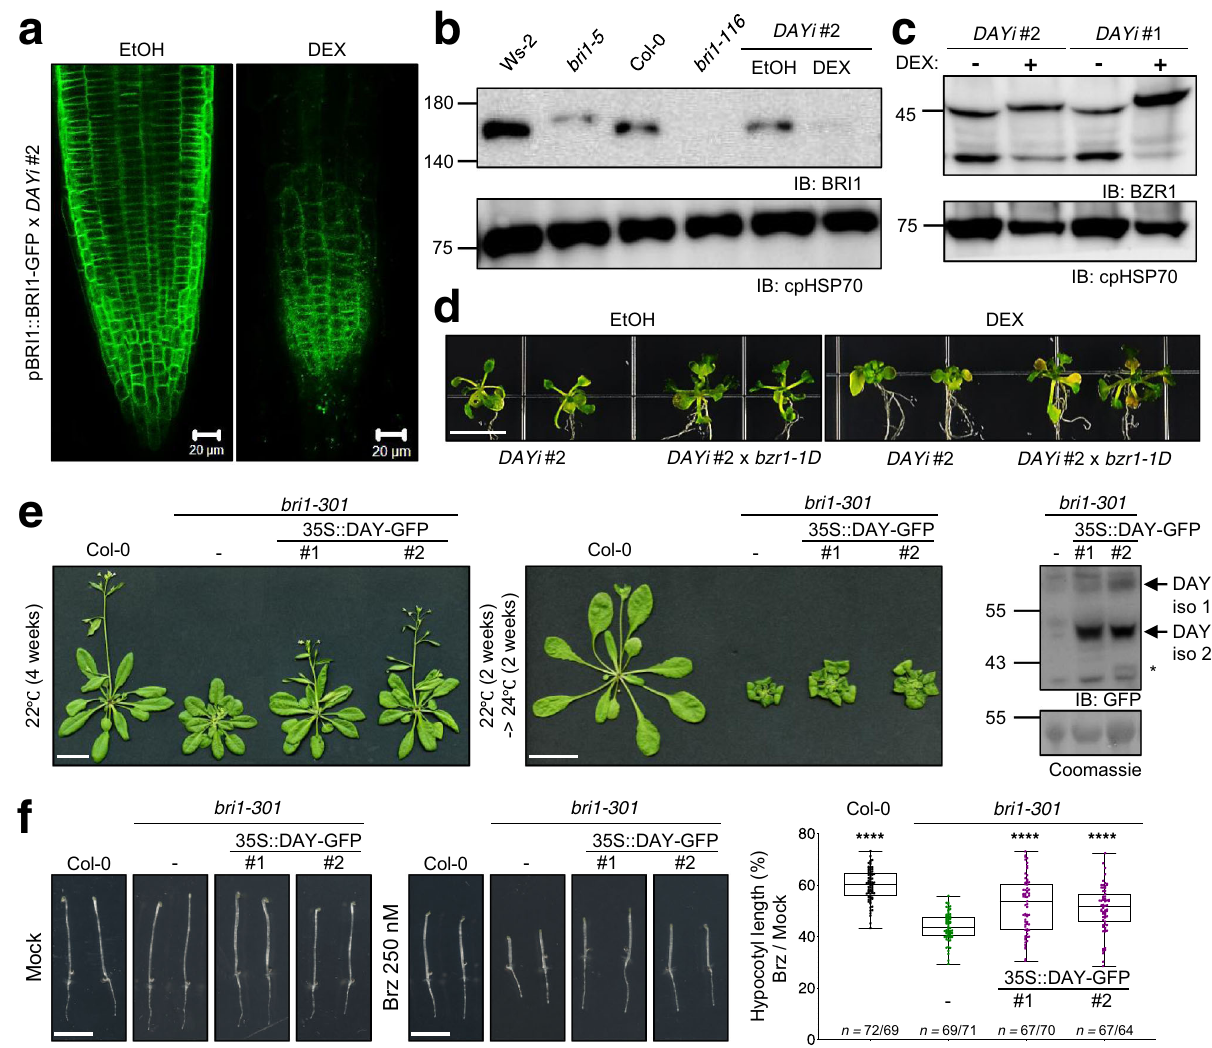
Fig. 4 DAY regulates BRI1 stability. a DAY de fi ciency triggers BRI1 instability. DAY silencing causes aggregation of BRI1-GFP in Arabidopsis roots. The pBRI1::BRI1-GFP × DAYi seedlings were grown in medium containing ethanol or 1 µ M DEX in the light for 9 days, and their roots were observed by CLSM. Scale bar, 20 µ m. b DAY silencing decreases BRI1 protein levels. 9-day-old seedlings of WT (Ws-2 and Col-0), bri1 mutants ( bri1 – 5 and bri1-116 ), and DAYi plants grown in the presence of ethanol or 1 μ M DEX were subjected to immunoblotting with anti-BRI1 and anti-cpHSP70 antibodies. c DAY silencing increases phosphorylated BZR1. 9-day-old DAYi seedlings grown in the presence of ethanol or 1 μ M DEX were subjected to immunoblotting using anti-BZR1 and anti-cpHSP70 antibodies. d , The dominant mutation bzr1-1D rescues the short petiole phenotype, but not chloroplast defect, of DAY -silenced seedlings. Seedlings from DAYi and DAYi x bzr1-1D lines were grown on 1/2 MS medium for 5 days at 22 °C and then transferred to medium containing ethanol or 1 µ M DEX at 28 °C for 7 days. Scale bar, 1 cm. e , f , Overexpression of DAY partially rescues a BR signaling mutant. Plants were grown in soil for 4 weeks at 22 °C ( e , left panel ) or 2 weeks at 22 °C and then transferred to 24 °C for 2 weeks ( e , middle panel ). Expression of DAY-GFP protein in bri1-301 mutant was shown by immunoblotting with anti-GFP antibody ( e , right panel ). Morphology of 5-day-old dark-grown seedlings of wild-type, bri1-301 , 35 S::DAY-GFP / bri1-301 #1 and #2 transgenic lines on medium in the absence ( f , left panel ) or presence of 250 nM brassinazole (Brz) ( f , middle panel ). Hypocotyl lengths are quanti fi ed relative to those of mock-treated samples ( f , right panel ). Genotypes are indicated. Dots represent individual ratio values (%) between mock- treated and Brz-treated independent seedlings. n denotes numbers of biologically independent hypocotyls, Brz- (left number ), and mock-treated ( right number ). Statistical signi fi cance was determined by one-way ANOVA, Dunnett ’ s multiple comparisons test **** P < 0.0001. Scale bars: 3 cm ( e ) or 1 cm ( f ). and growth retardation phenotypes in bri1-301 (Fig. 4e). We also especially in the dark (Supplementary Figs. 17 – 19). Collectively, measured hypocotyl length of 35S::DAY-GFP / bri1-301 in the these data indicate that DAY acts as a positive regulator of BR dark with or without Brz. DAY overexpression partially rescued signaling. Brz hypersensitivity in bri1-301 in the dark (Fig. 4f). Since enhances BR signaling, possibly via BRI1 stabilization, we performed RNA-Seq on seedlings of DAYi DAY interacts with BRI1 in the endomembrane system . Since and the bri1 null mutant allele bri1-116 . We compared the DAY promoted BR signaling via BRI1, we used BiFC to test transcriptomes of DAYi and bri1-116 seedlings grown in the whether DAY and BRI1 interact in the endomembrane system. dark or light. We found that the transcriptome of DAYi seedlings signi fi cantly overlaps with that of the bri1-116 mutant, NATURE COMMUNICATIONS| (2021) 12:4194